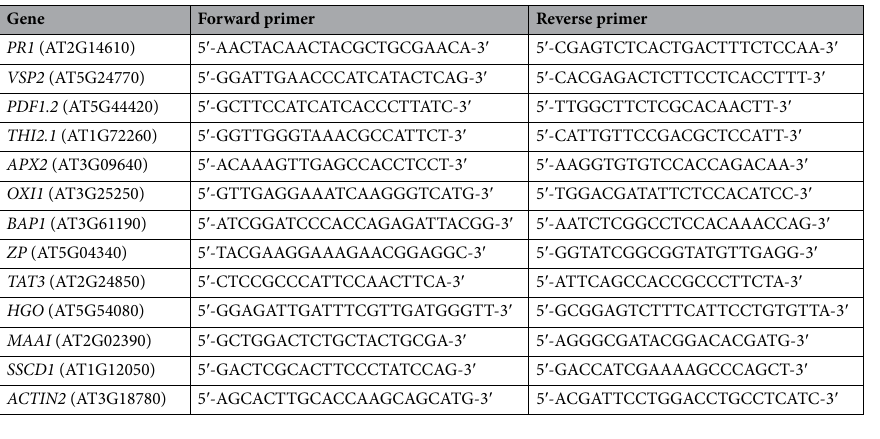
Table 1. Primers of genes tested by